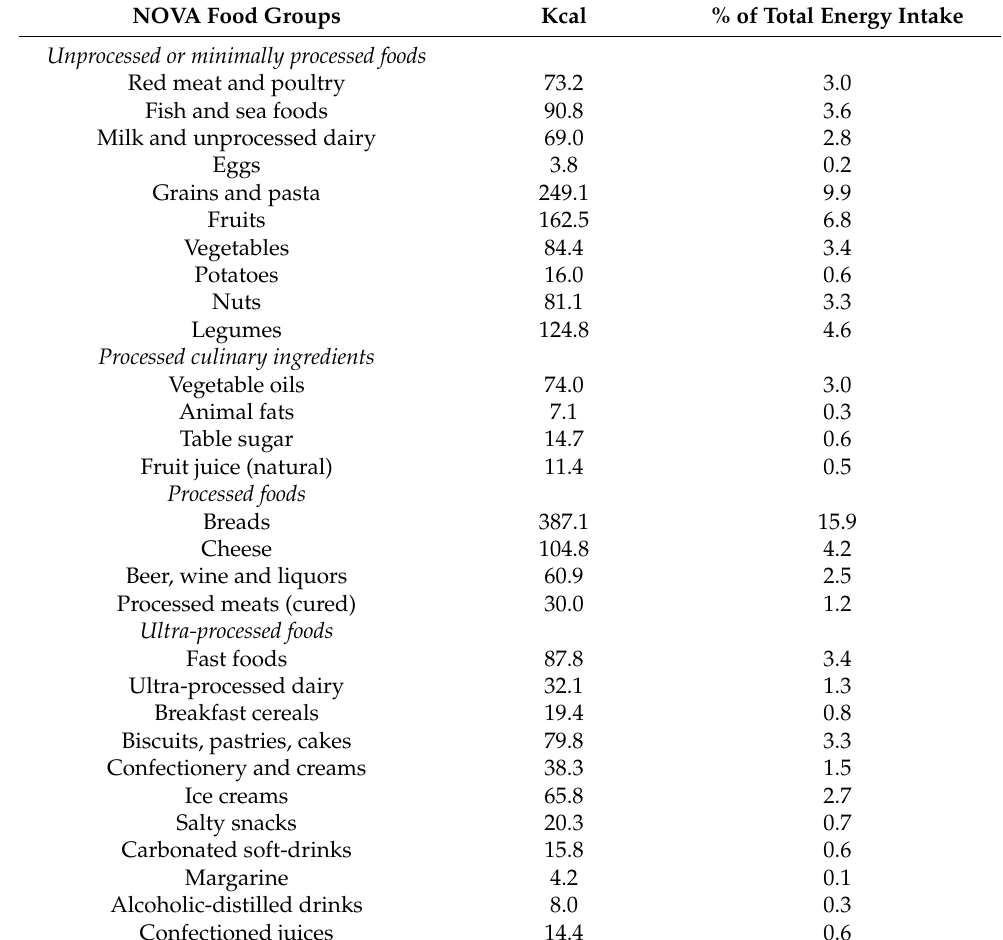
Table 1. Mean absolute and relative daily energy intake according to NOVA food groups in the study sample ( n =